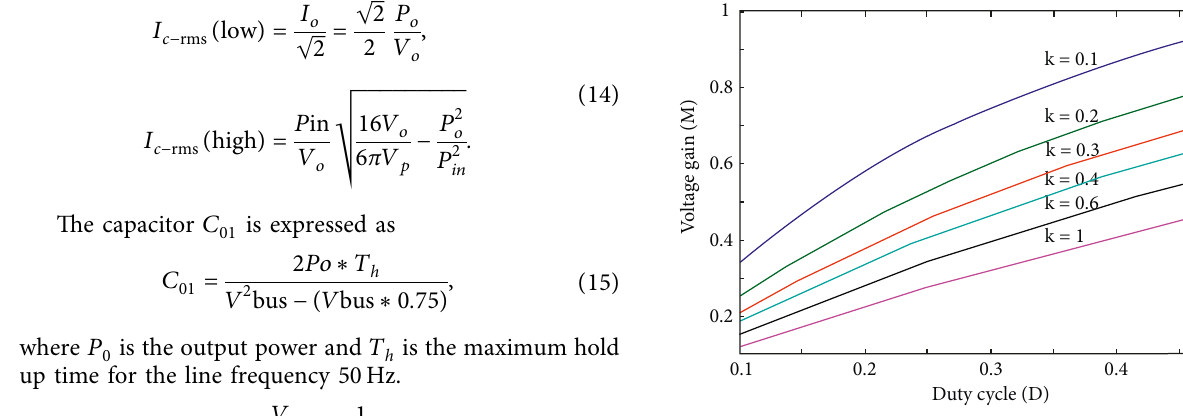
Figure 6: Voltage gain ( M ) versus duty cycle ( D ) plot for different values of k . Table 1: Specifications of the proposed